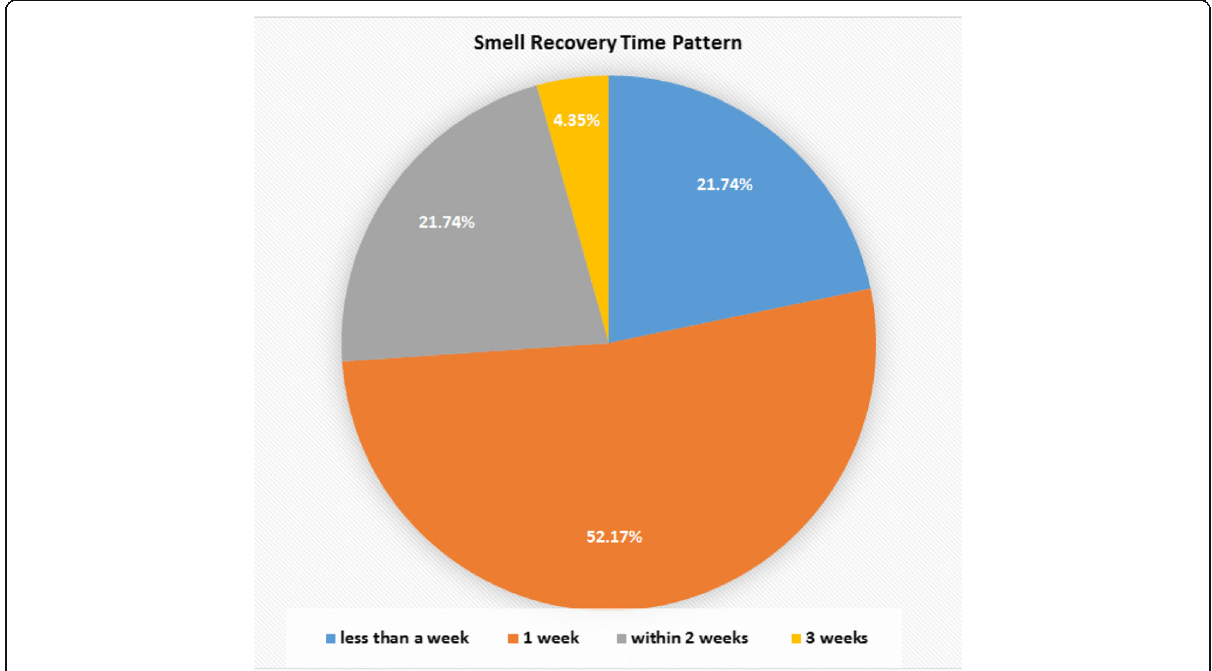
Fig. 4 The percentage of smell recovery in the corresponding